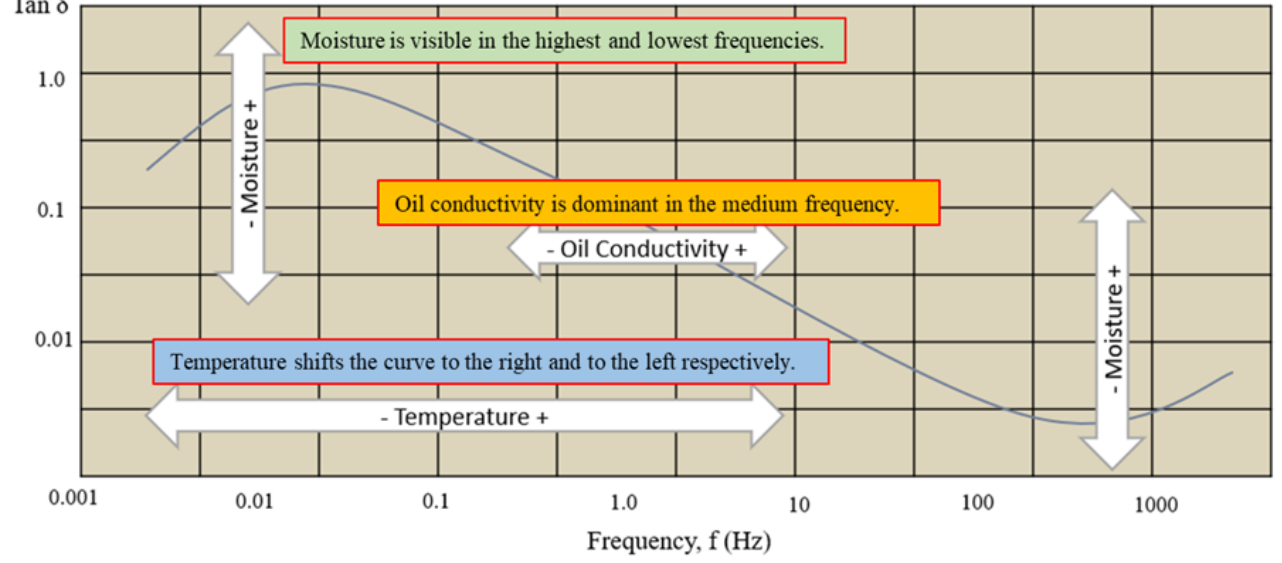
Figure 10. Influence of moisture and oil conductivity on tan δ curve [93].